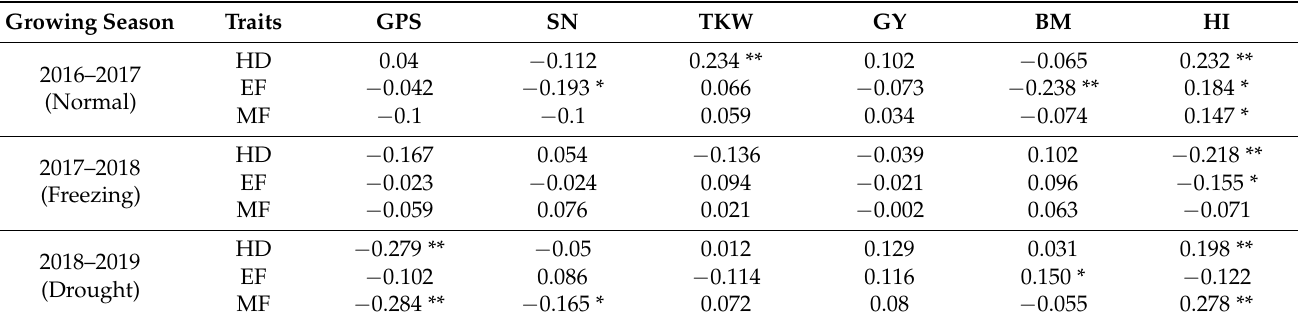
Table 3. Correlations between CTDs at three growth stages with the yield traits of the three grow- ing